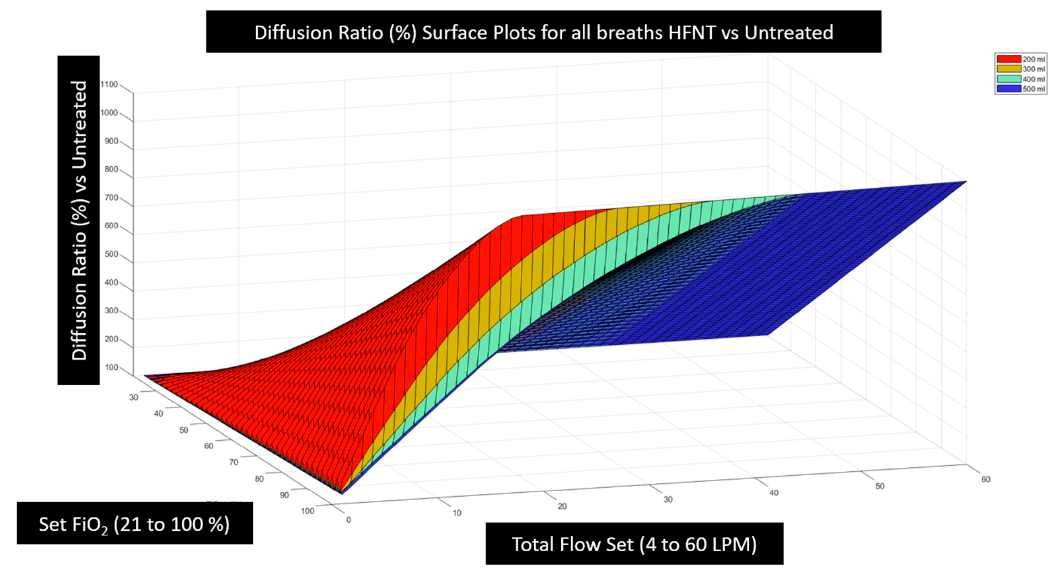
Figure 10. The effectiveness surfaces are drawn together as breath size (PIF) varies. A comparison of HFNT effectiveness at different settings shows that as breaths get larger, the effectiveness of the treatment at the same settings is diminished unless the flow setting is sufficiently large to support the greatest PIF. If the maximum PIF is supported, the effectiveness is maintained; however, there is no additional benefit indicated with increases in flow above the PIF (shown by the flat surface in the vertical dimension on the right side of the plot above). Therefore, the model shows that effectiveness is optimized at a given F i O 2 setting when the flow is set at or above the